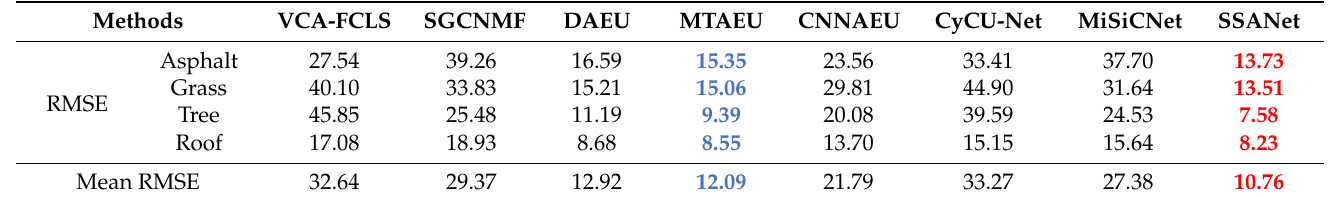
Table 8. RMSE ( × 100) and mean RMSE ( × 100) of abundances acquired by various unmixing approaches on Urban data. Annotation: bold red text indicates the best results and bold blue text indicates the suboptimal results.